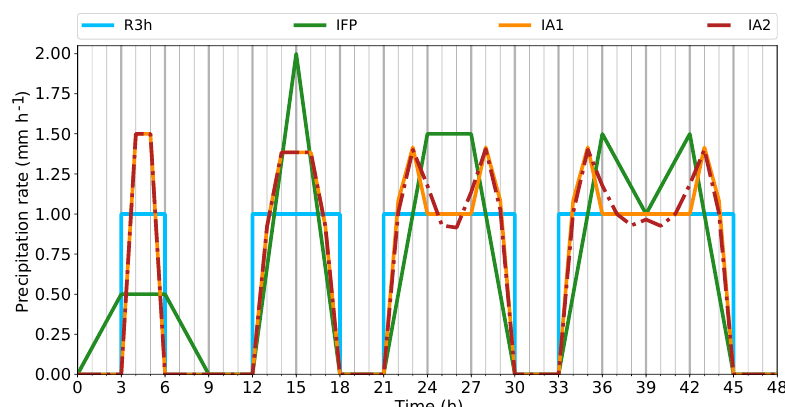
Figure 10. Verification of the interpolation algorithms for four simple precipitation events. The 3-hourly synthetic precipitation rate (S3h) is illustrated as a step function in light blue. Reconstructions are shown as linear connections of their respective supporting points, with the current FLEXPART algorithm (IFP) in green, the newly developed algorithm IA1 in orange, and IA2 (also new) in red (dashed–dotted).